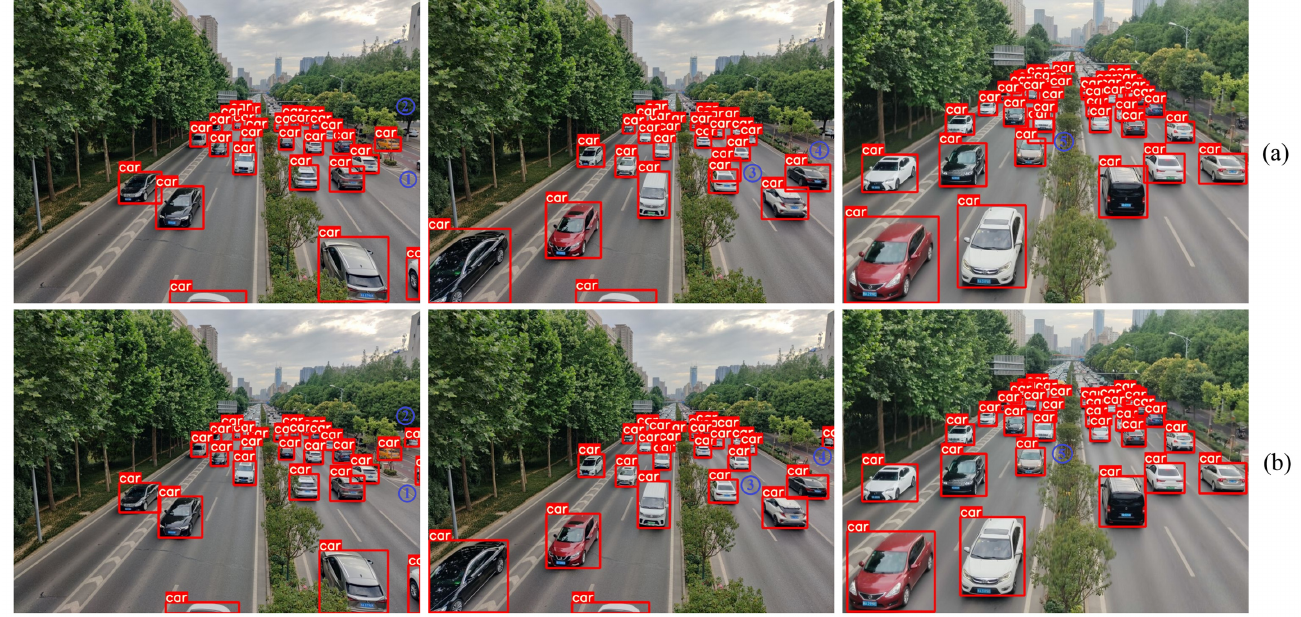
Figure 10. Comparison of original and added DIoU ‐ NMS networks (( a ) for the original network; ( b ) for added DIoU ‐ NMS network).